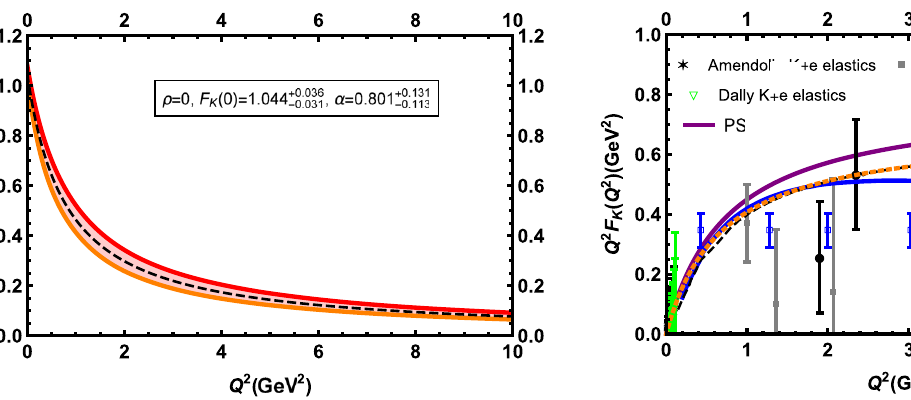
Fig. 9 Q 2 F K ( Q 2 ) with respect to Q 2 . The result of present study (PS) is represented with the solid purple line. The black stars and green triangles show experimental data taken from Refs. [21,22]. The filled squares corresponds to kaon electromagnetic form factor from E93-018 and FPI-2. The filled circles data were extracted form the cross section dataofRefs.[31,32].Bluepointswitherrorbarsarenotdatapoints,they represent the Q 2 range and projected uncertainties of the E12-09-011 JLab experiment [31]. The dashed black curve shows the predictions of Refs. [22,33]. The dotted orange line is borrowed from Ref. [29]. The solid blue line shows the kaon form factor obtained in Ref.